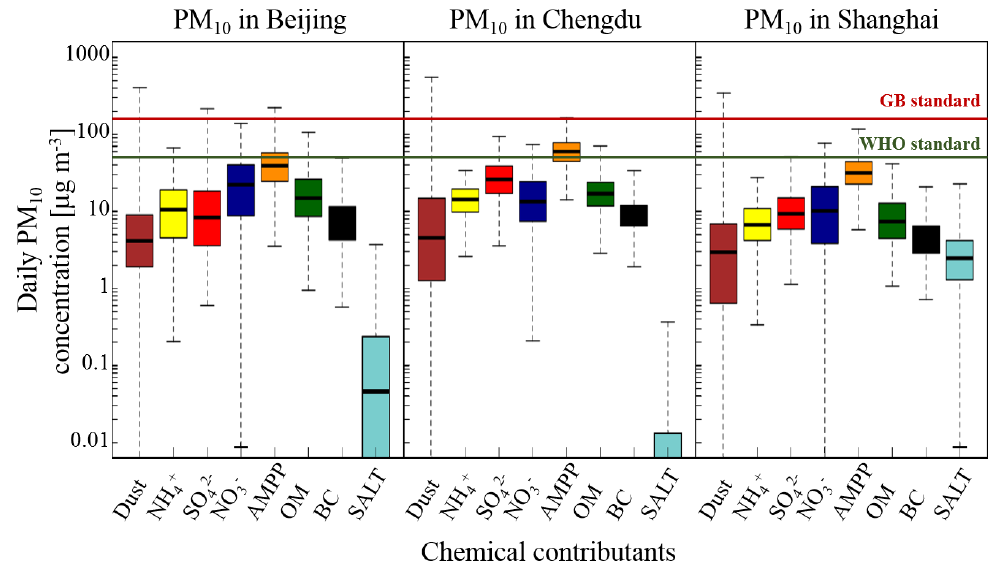
Figure 6. Boxplot distribution for simulated daily concentrations (1095days considered) of species contributing to PM 10 . ( left ) Beijing ( center ) Chengdu and ( right ) Shanghai. Model species correspond to: Dust (only representing the desert and natural fraction), NH + NO − (nitrate), AMPP (Anthropogenic Mineral Primary Particulate matter—including soil 3 ( p )